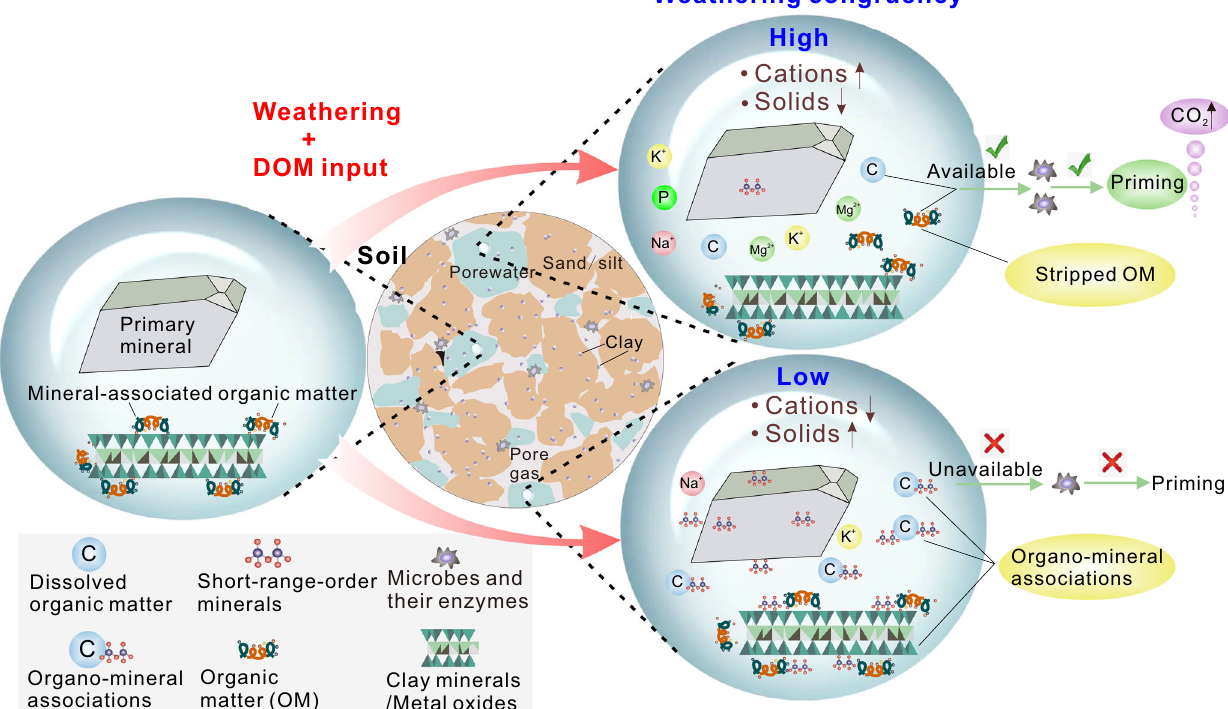
Fig.1|Aconceptualmodelshowingtherelationshipofweatheringcongruency to the priming effect. Mineral breakdown at high and low weathering con- gruencies results in different proportions of dissolved vs. solid-phase products (Table 1). High weathering congruency yields more dissolved cations and fewer solids relative to low congruency. Low congruency generates more short-range- order minerals thatcanbond with and protect organic matter(including dissolved